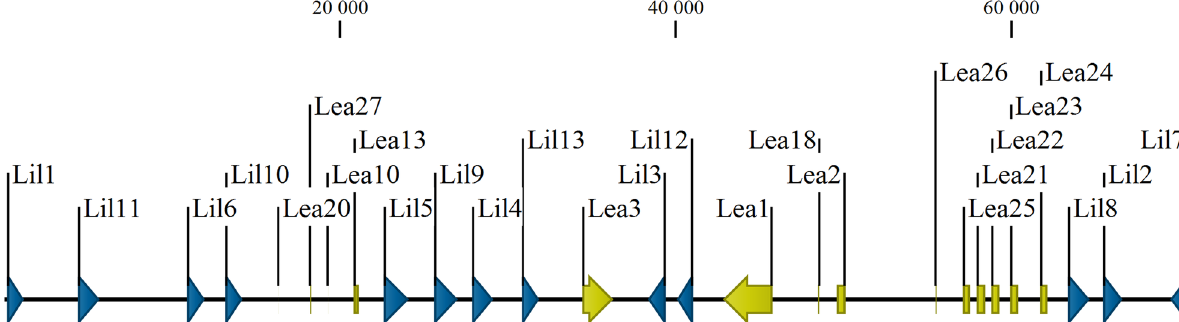
Figure 1. The localization of PvLea and PvLil genes in the ARId1. Schematic of a part of the ARId1 region (nucleotides 27,300:98,100) incorporating all PvLil genes. Genes are represented by arrows and boxes, whose colour indicates different types of genes: PvLil (blue) and PvLea (yellow). The prefix “Pv” and annotations of six genes that are not related to LEA were removed for